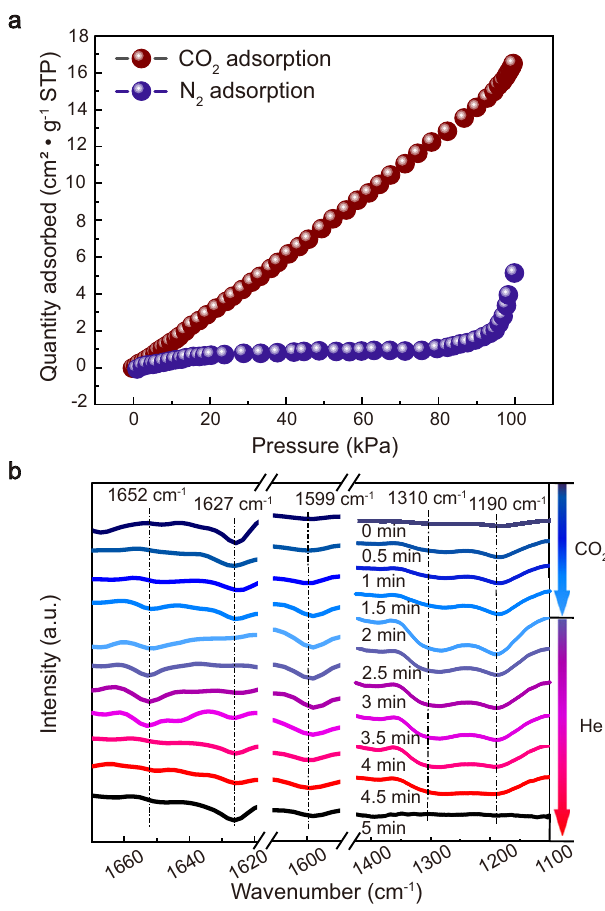
Fig. 6 Study on CO 2 selective transmission mechanism. a Pure-component CO 2 and N 2 adsorption in (LDH/FAS) 25 -PDMS membrane. b In situ DRIFTS spectra of (LDH/FAS) 25 -PDMS membrane upon CO 2 (within 0 − 2min) adsorption and subsequent He adsorption (within 2 −